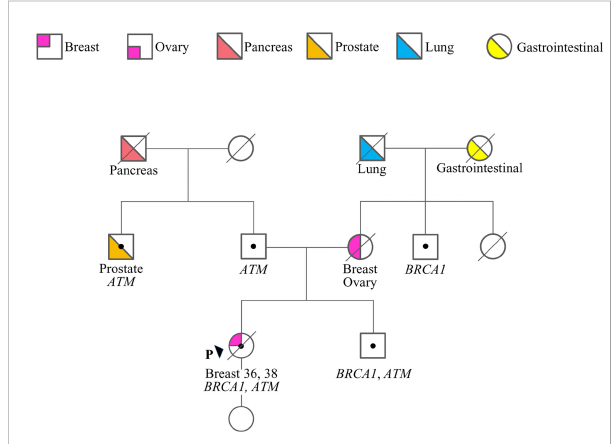
FIGURE 1 Family pedigree. Males and females are indicated by squares and circles, respectively. The proband (P) is indicated by the arrow. The ages of cancer diagnosis (proband only) and the phenotypes of affected family members are reported under the corresponding symbols, when known. Diagonal slashes indicate deceased individuals. Individuals who underwent genetic analysis are indicated by dots and the genes found mutated are